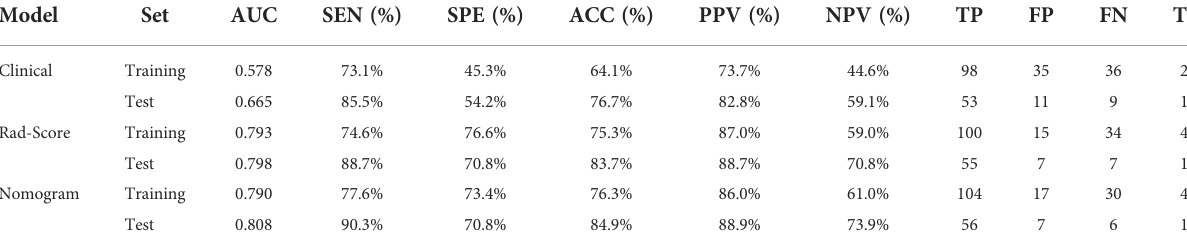
TABLE 6 Predictive performances of the models predicting the Ki-67 status in patients with BC. Model